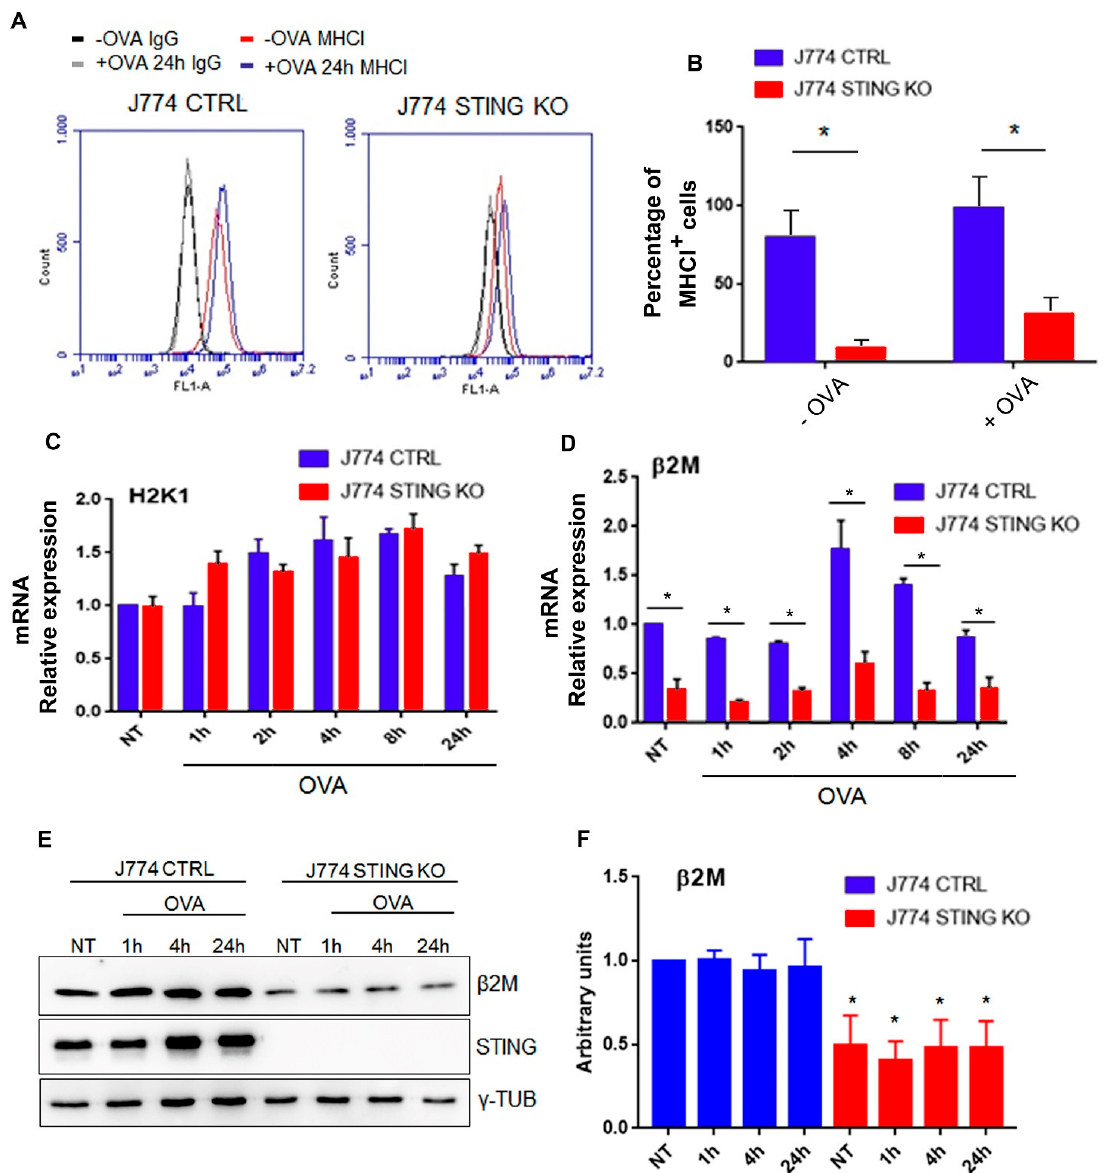
Figure 5. MHC-I expression on the plasma membrane and mRNA expression of H2K1 and β 2 m in control and STING KO macrophages. ( A ) J774 CTRL and STING KO cells (1 × 10 6 ) were treated with 500 µ g/mL of OVA for 24 h and were stained with MHC-I-FITC and IgG-FITC as a control. Each plot represents 10,000 events of a representative experiment. ( B ) Percentage of MHC-I-FITC- positive population in untreated or OVA treated cells. Values (mean ± SE, n = 5) are shown. The asterisks indicate a statistically significant difference compared to the untreated control, according to a Stu ‐ dent’s t ‐ test ( p < 0.01). ( C , D ) Cells (5 × 10 6 ) were stimulated with 500 μ g/mL of OVA for 1, 2, 4, 8, 24 h or left untreated. Total RNA was extracted and analyzed by RT ‐ qPCR to evaluate the gene expres ‐ sion of H2K1 ( C ) and 2 m ( D ). Values are presented as the mean ± SD of three independent exper ‐ iments. The asterisks indicate statistically significant differences between CTRL and KO cells, ac ‐ cording to a Student’s t test ( p < 0.01). ( E ) J774 CTRL and STING KO cells (5 × 10 6 ) were treated with 500 μ g/mL of OVA or left untreated for the indicated time. Whole cell extracts (30 μ g) were analyzed